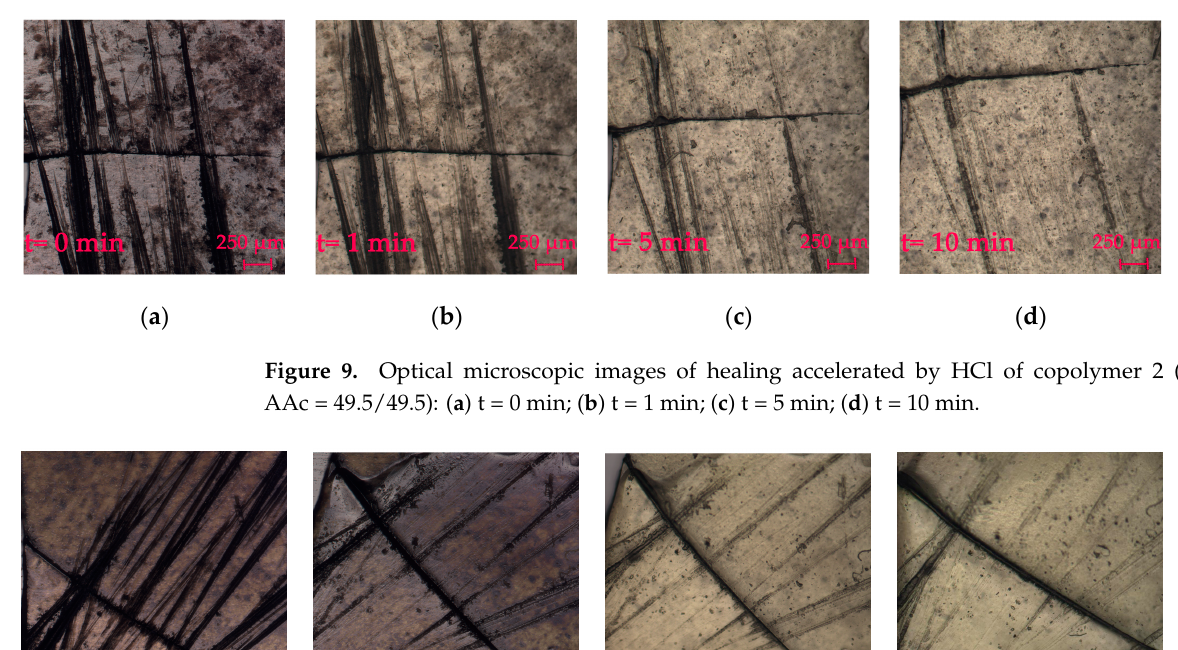
84.5/14.5): ( a ) t = 0 min; ( b ) t = 1 min; ( c ) t = 5 min; ( d ) t = 10 min.